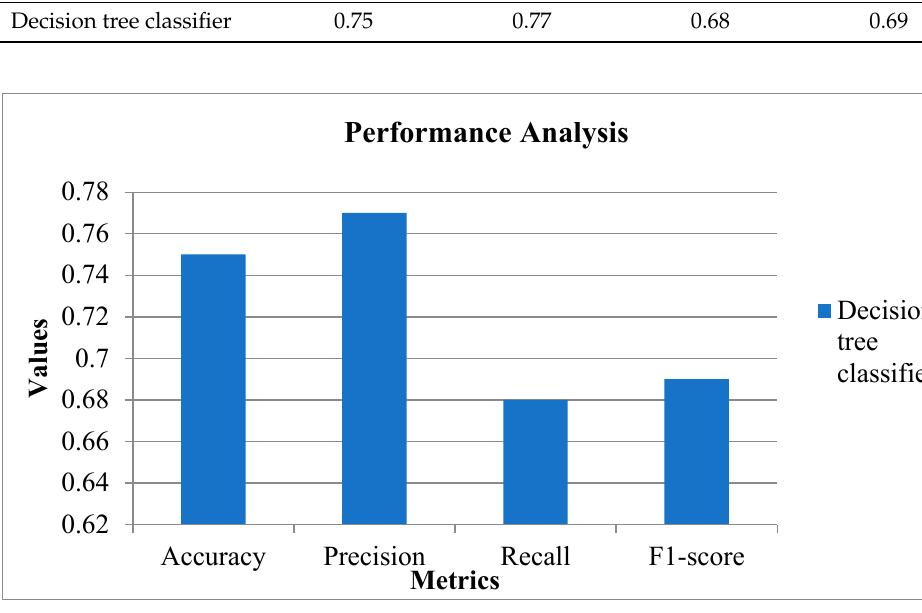
Figure 16. Performance analysis of the DT classifier.